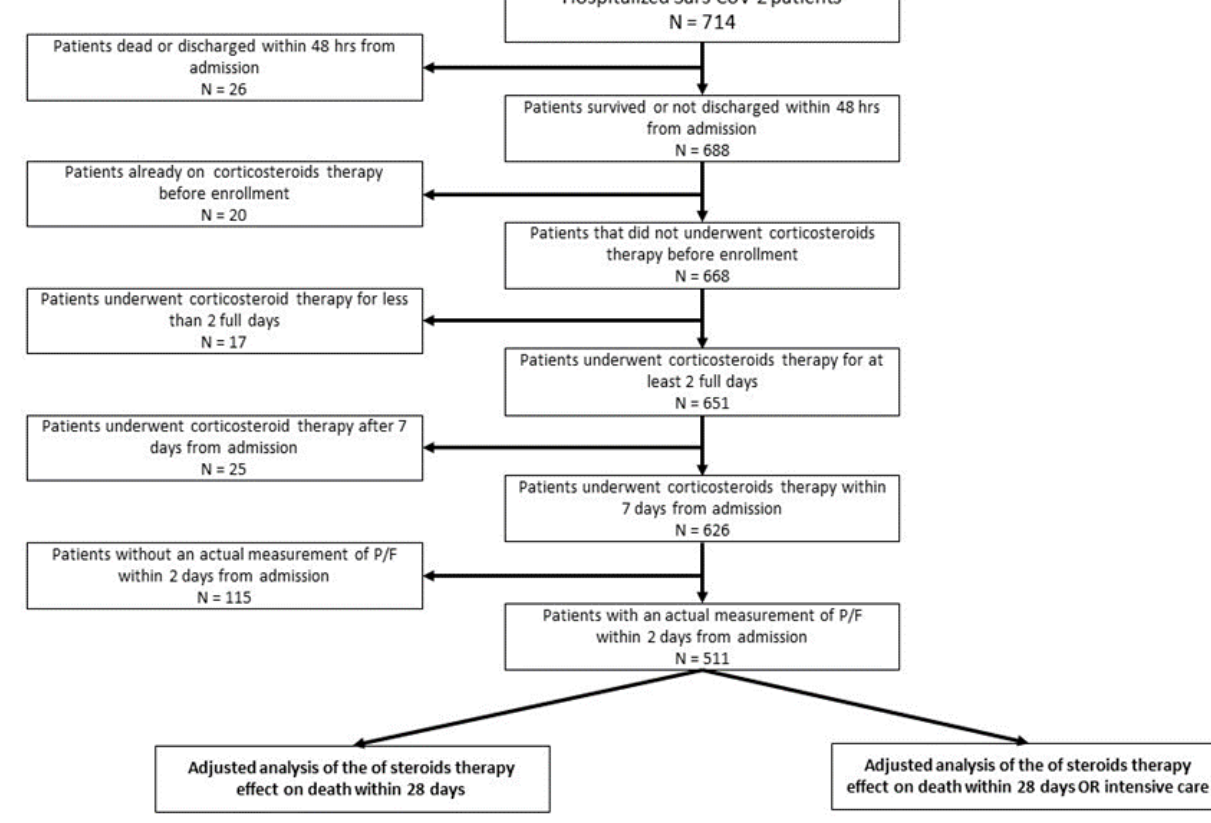
Figure 1. Flow chart of the present study.